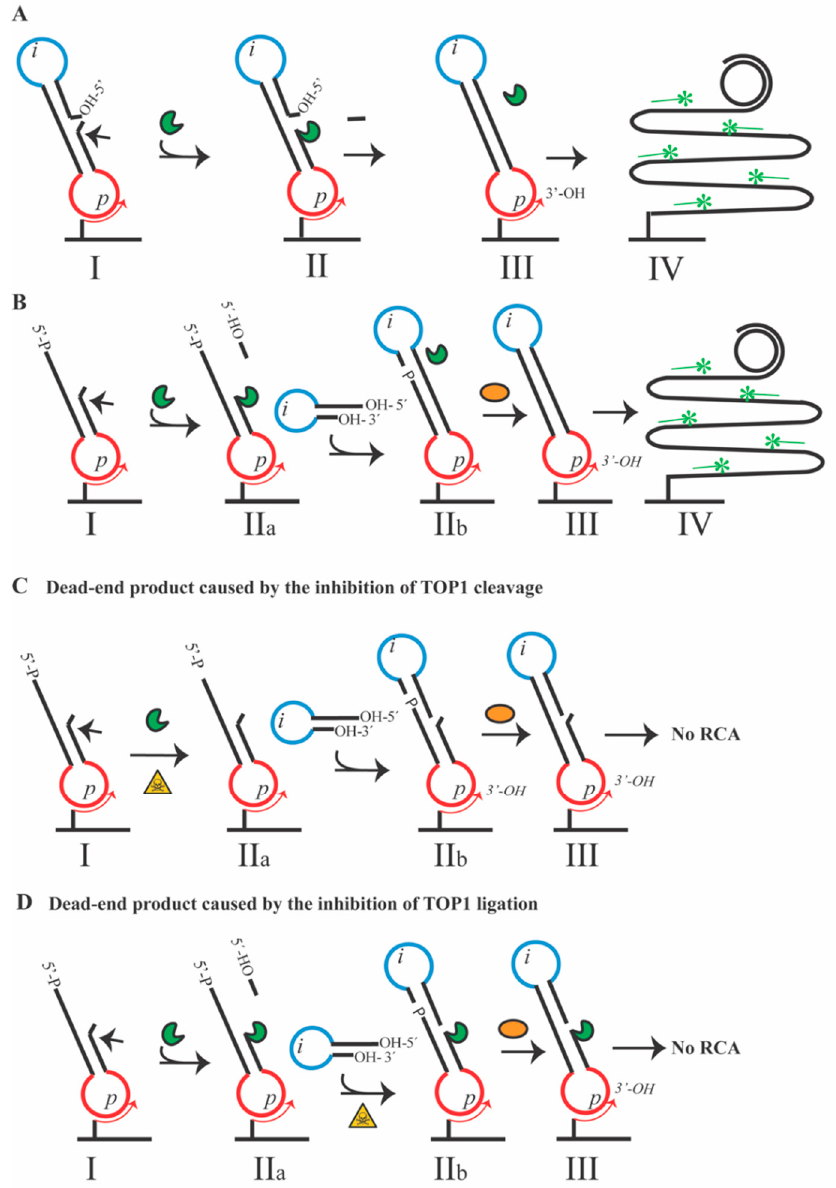
Figure 1. Schematic representation of the REEAD-on-a-slide and REEAD (C|L) assay setup. ( A ) The REEAD substrate folds into a dumbbell-shaped structure with one loop (red) containing a sequence matching the sequence of a primer attached to a glass slide and the other loop (blue) containing a sequence allowing hybridization of the RCP to a specific probe. The substrate contains a preferred TOP1 cleavage site (indicated by an arrow) and has a 5 (cid:48) -OH end suitable for TOP1 mediated ligation (I). Upon cleavage, a three-nucleotides fragment is released and diffuses away (II) while the 5 (cid:48) -OH is ligated by TOP1. Thereby, the open substrate is converted into a closed circle (III). The generated circle is amplified by RCA, mediated by the phi29 polymerase, and primed by the 3 (cid:48) -OH end of the primer (III–IV). Fluorescently labeled probes are hybridized to the RCP allowing for the visualization in a fluorescence microscope (IV). ( B ) The cleavage half-dumbbell substrate folds into a partially double-stranded molecule with one loop (red) containing a sequence allowing hybridization to a surface-attached primer. The preferred TOP1 cleavage site is situated three bases upstream of the 3 (cid:48) end of the half-dumbbell structure, indicated by an arrow (I). Upon cleavage, TOP1 is covalently bound to the 3 (cid:48) end of the cleavage half-dumbbell and ligation is prevented by the diffusion of